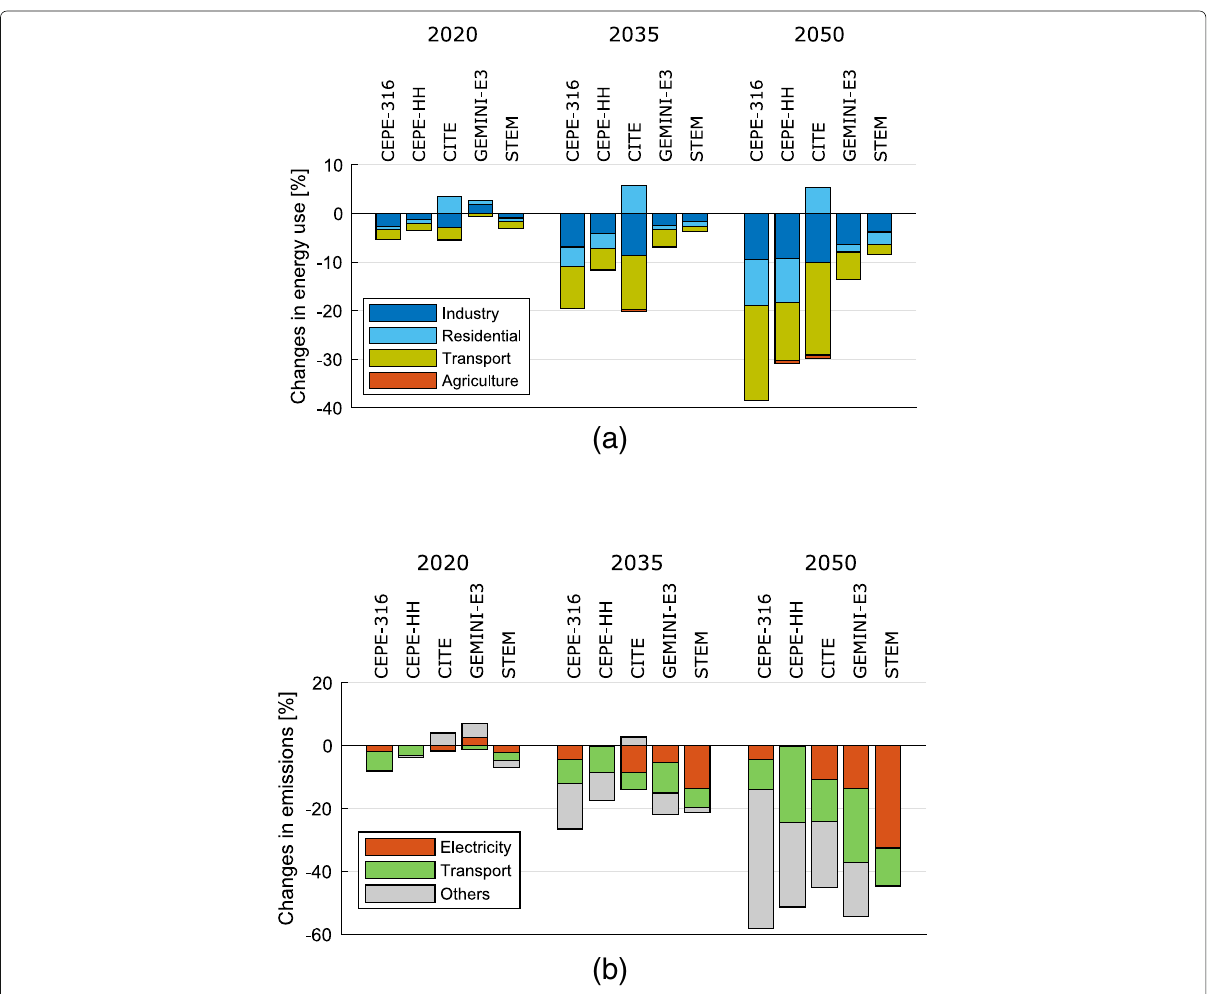
Fig. 3 Changes in energy use (above) and emissions (below) by economic activity in the 1.5_uni scenario compared to BAU. a Changes in energy use. The category industry includes the service sector. b Changes in emissions